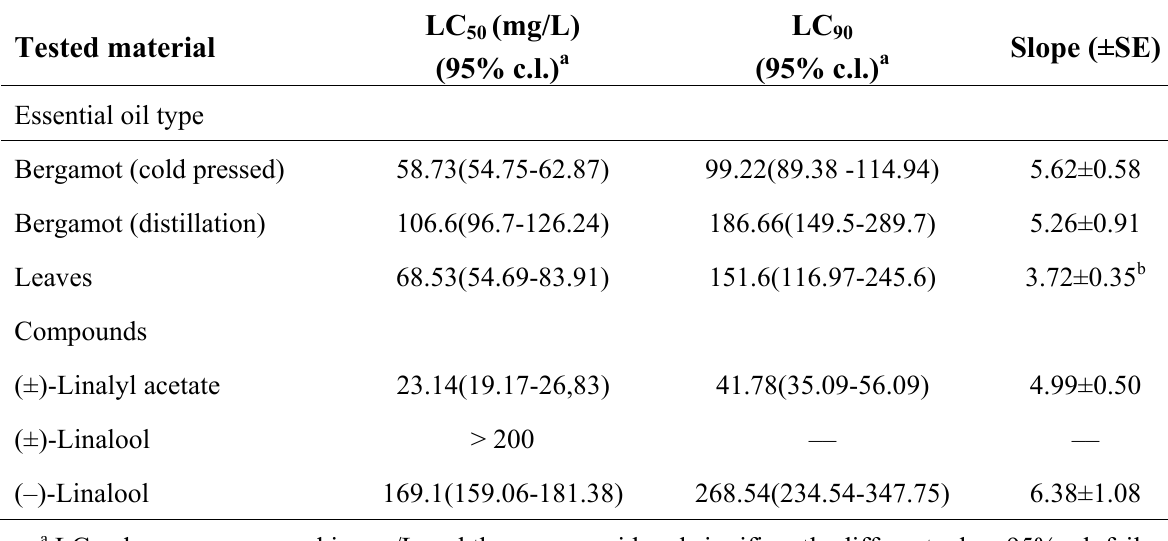
and LC values for the bergamot fruit and leaves essential oil against Table 3. LC 50 90